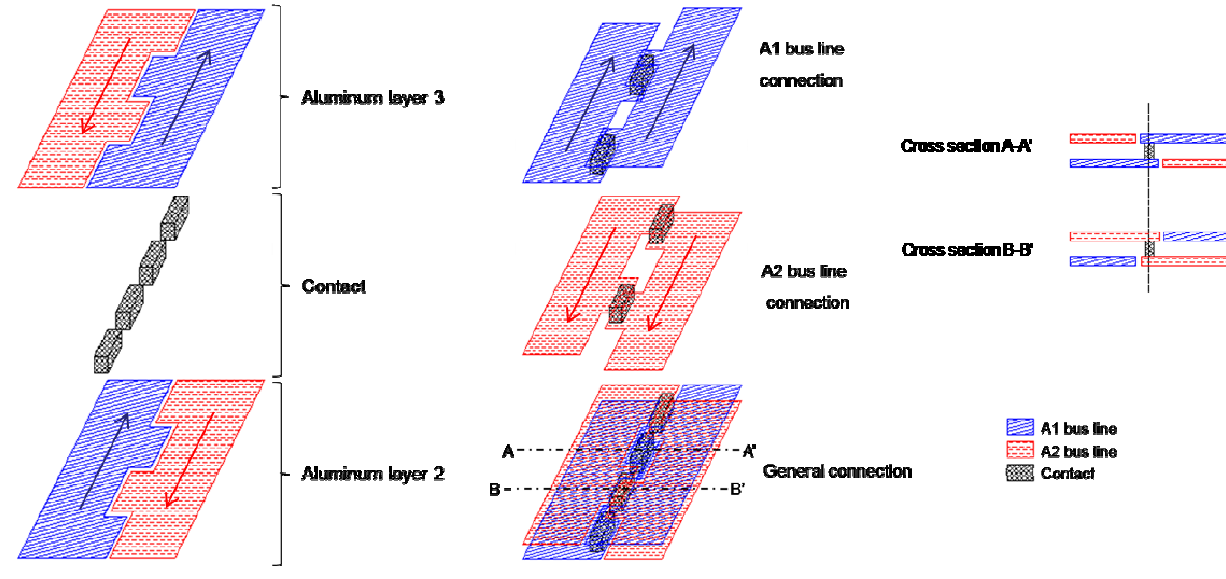
Figure 13. Crossed bundling concept for A1 and A2 bus